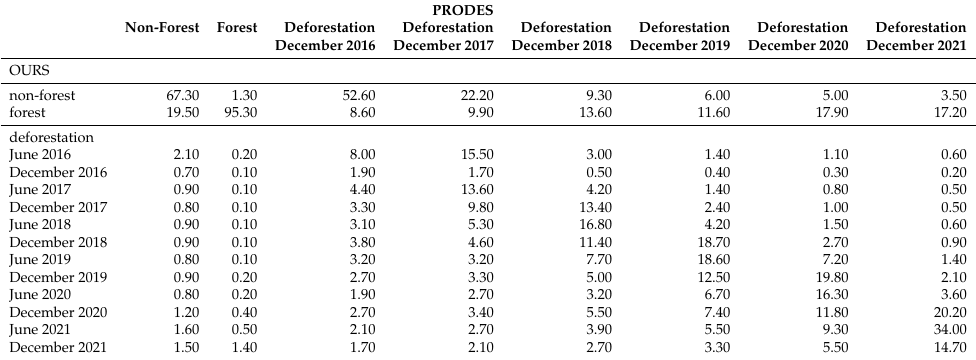
Table 3. Intersection in percentage of annual PRODES data and our bi-annual deforestation product. PRODES Non-Forest Forest Deforestation Deforestation Deforestation Deforestation Deforestation